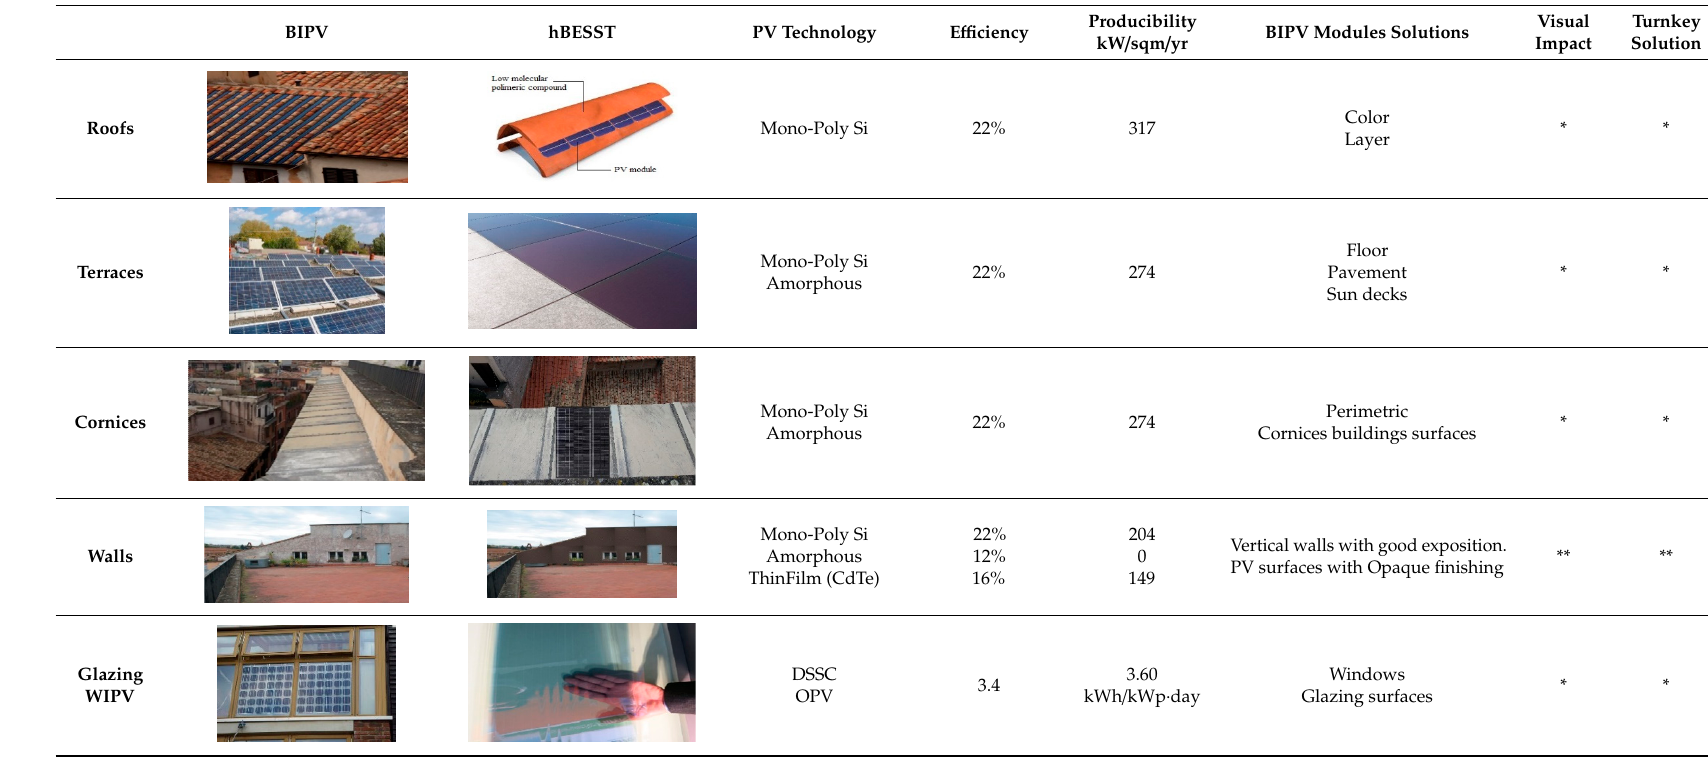
Table 9. Comparison between traditional BIPV and BHESST solutions on historical building envelopes and technological and visual impact